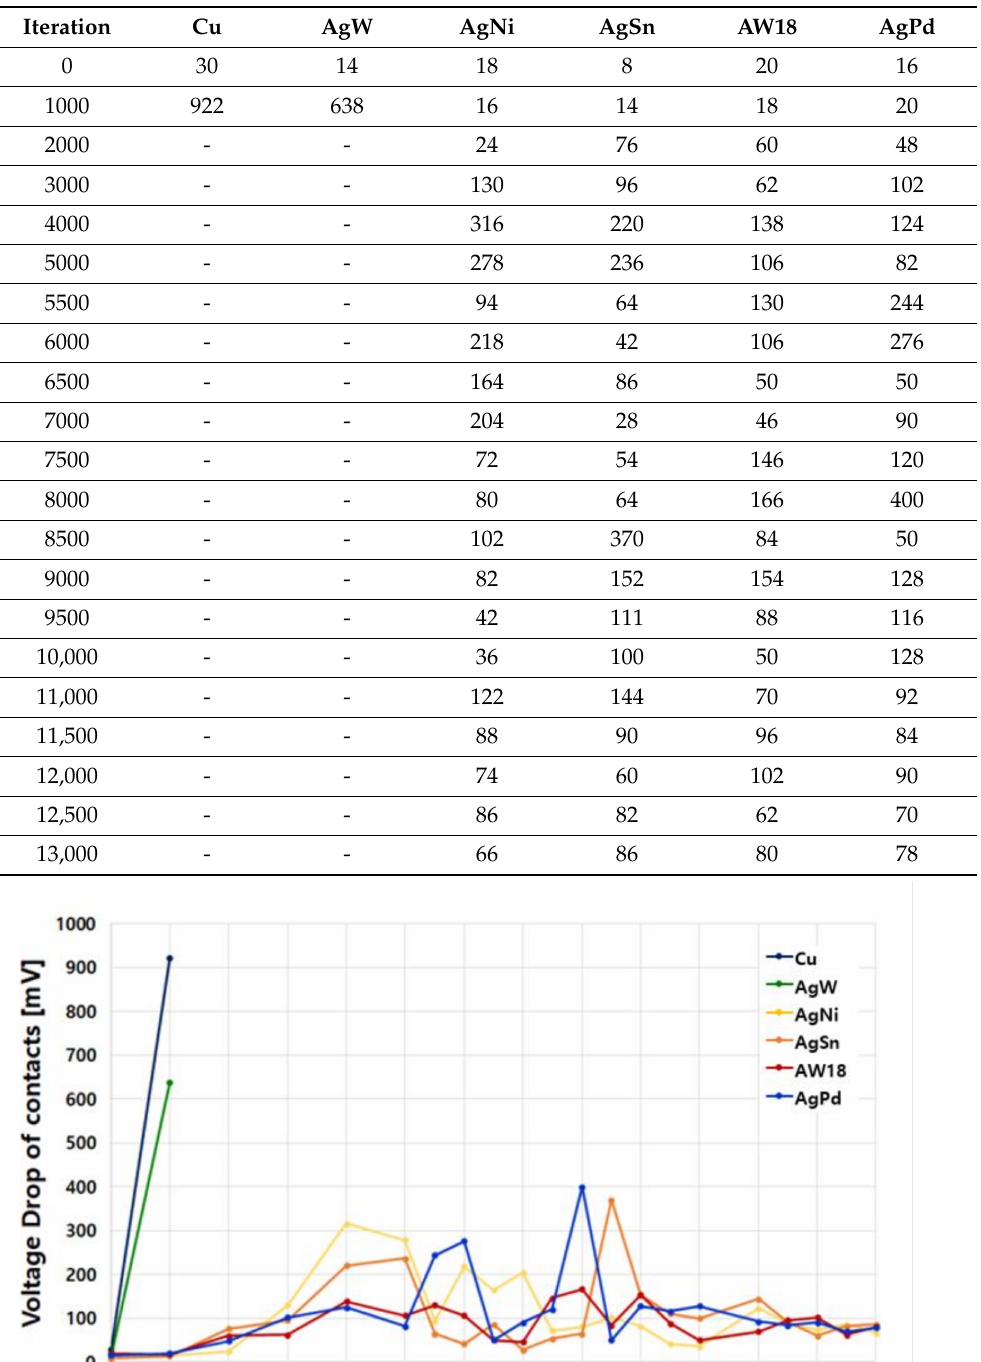
Table 3. Voltage drop between switch contacts under 400 V/5 A load conditions.